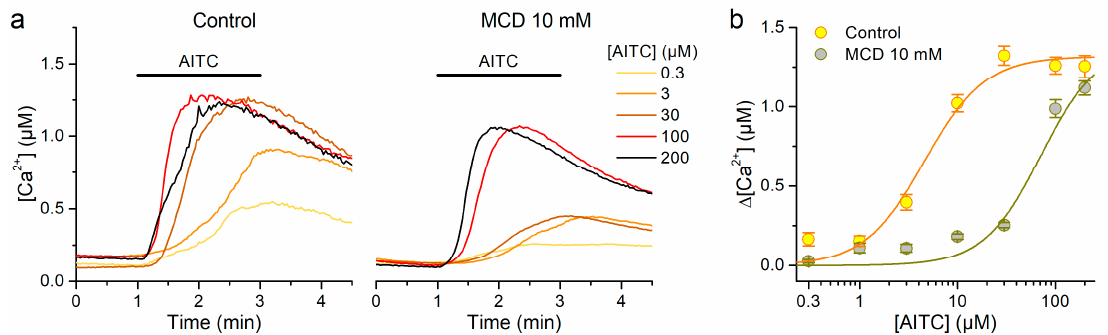
Figure 5. Effects of cholesterol depletion using MCD on mTRPA1 activation by AITC in stably transfected CHO-K1 cells. ( a ) Mean traces of Ca 2+ responses to different concentrations of AITC in control (left panel) or after treatment with 10 mM MCD (right panel; n = 63–178). ( b ) Dose-response curves of the amplitude of the Ca 2+ responses to AITC averaged over different cells. The lines represent fits with Hill functions with parameters EC 50 = 4.6 ± 1.1 µM and 70 ± 20 µM, Δ [Ca 2+ ] MAX = 1.32 ± 0.09 µM and 1.4 ± 0.3 µM and H = 1.4 ± 0.3 and 1.5 ± 0.5, for control and MCD 10 mM, respectively.